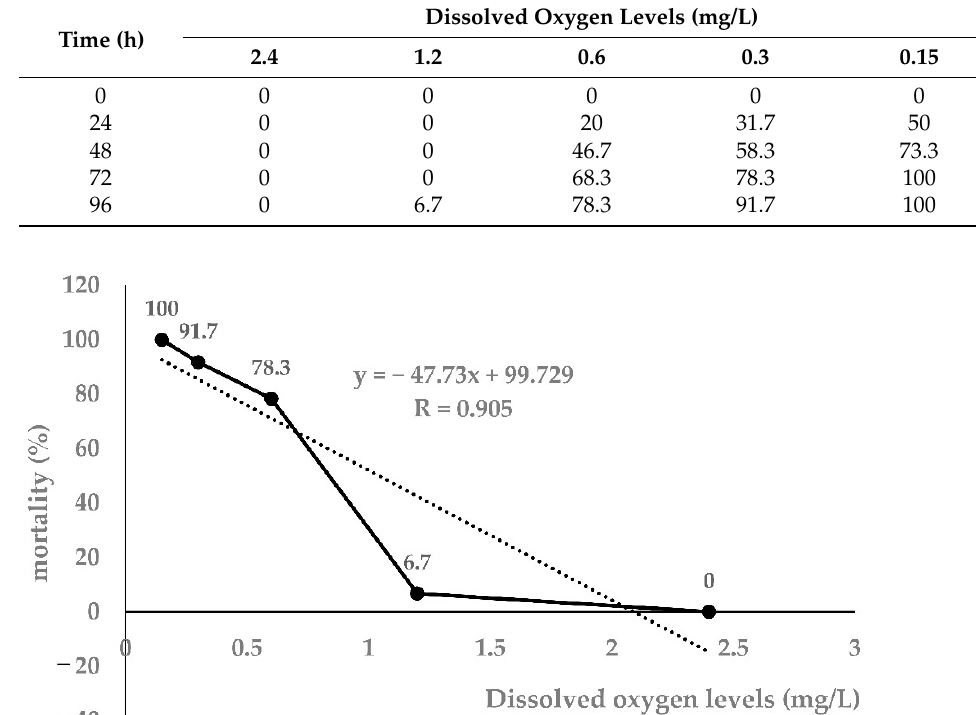
Table 1. Effects of different low DO levels on 96h mortality (%) of largemouth bass. Dissolved Oxygen Levels (mg/L) Time (h)